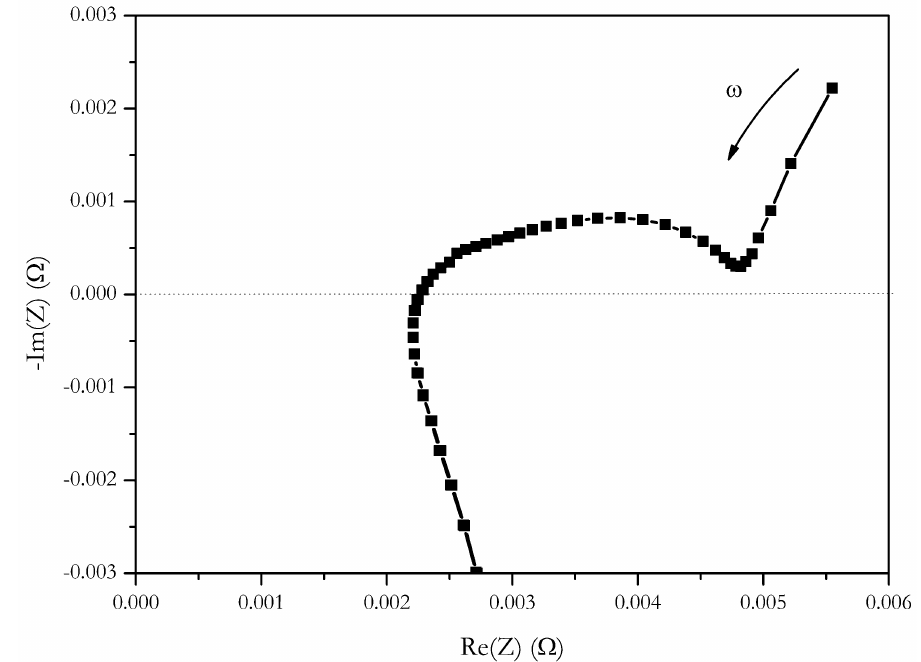
Figure 11. Nyquist plot of the NX2P0M cell.